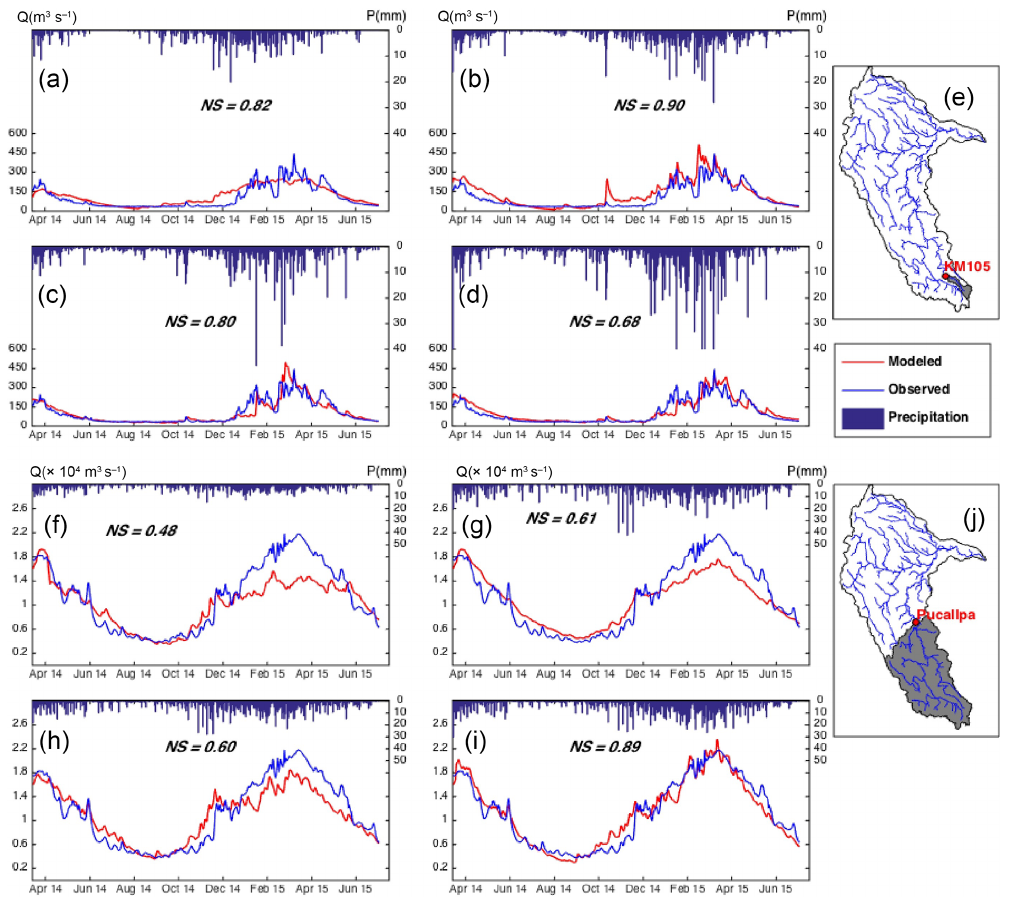
Figure 6. Observed and simulated streamflow hydrographs at KM105 station from 12 March 2014, to 30 June 2015, using the following precipitation datasets: (a) observed rainfall, (b) GPM-IMERG, (c) TMPA V7 and (d) TMPA RT. (e) Location of the drainage area controlled at the KM station. Observed and simulated streamflow hydrographs at the Pucallpa station from 12 March 2014, to 30 June 2015, using the following precipitation datasets: (f) observed rainfall, (g) GPM-IMERG, (h) TMPA V7 and (i) TMPA RT. (j) Location of the drainage area controlled at the Pucallpa station.